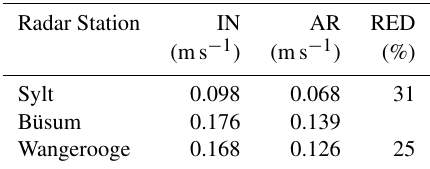
Table 4. Spatially and temporally averaged innovations (IN; ms − 1 ), analysis residuals (AR; ms − 1 ), and percentage reduction (RED) in the radial component differences after analysis with re- spect to the three radar stations.